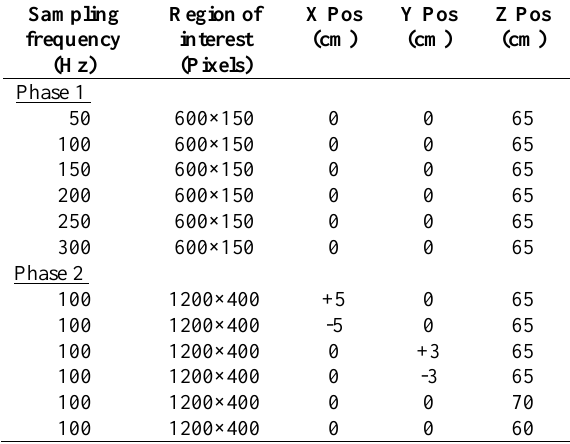
Table 1. Summary of the various combinations of settings that were used during the experiment